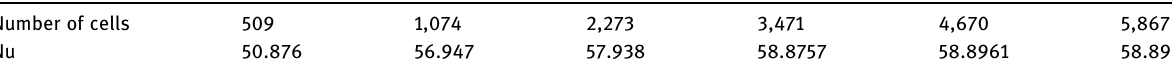
Table 3: Results of grid independence study Number of